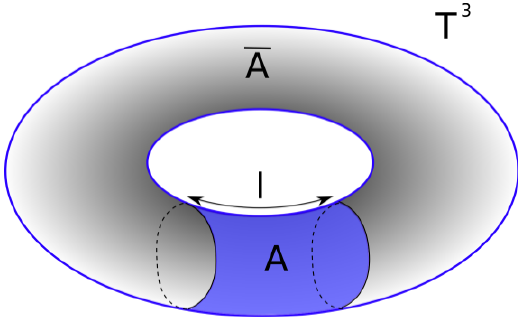
Figure 12 . A region with linear size l in the compact space which has T 3